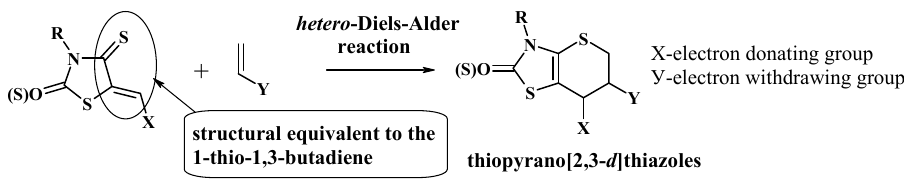
Figure 2. 5-arylidene-4-thiazolidinethiones as heterodienes.